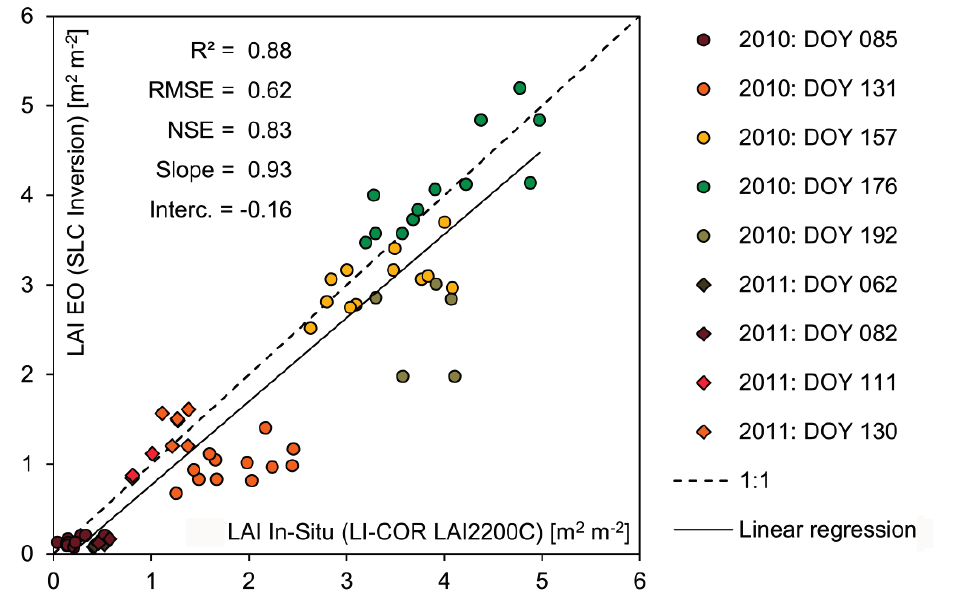
Figure 4. Validation of winter wheat green Leaf Area Index retrieval from RapidEye